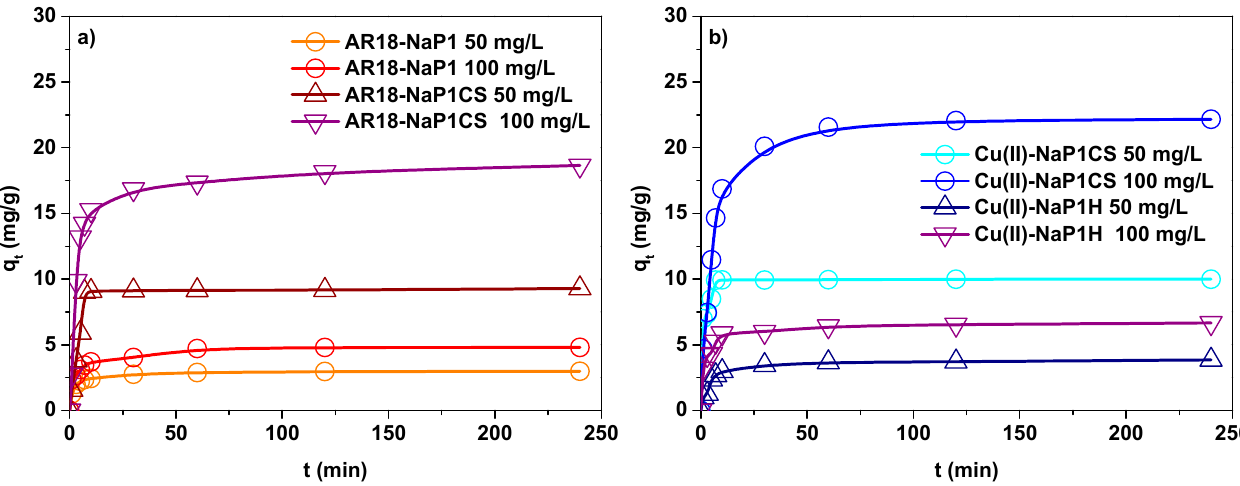
Figure 6. Concentration effect of ( a ) AR18 and ( b ) Cu(II) adsorption on NaP1CS (m = 0.1 g, t = 120 min., A = 7, 180 rpm, pH = 6).